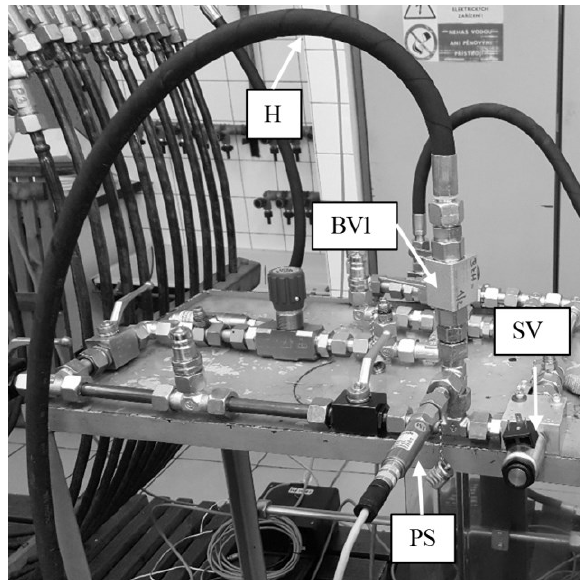
Fig. 2. Connected hydraulic hose